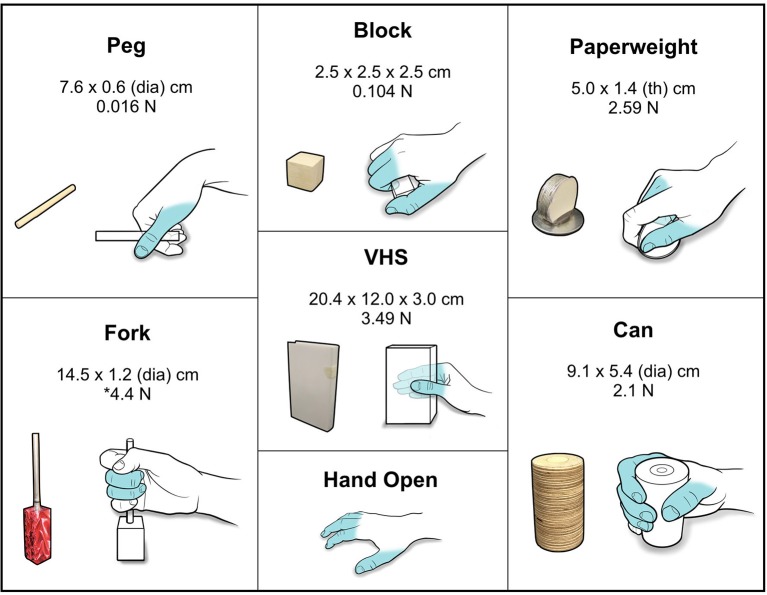
Standardized GRT objects and functional grasps. Schematic showing the different GRT objects with associated dimensions and weights. Hand schematics illustrate the grasp/movement enabled by FES for the object. Fingers that were activated and used to perform the grasps/movements are highlighted in blue. *For the Fork object, a 4.4 N force is required to depress the cylinder.